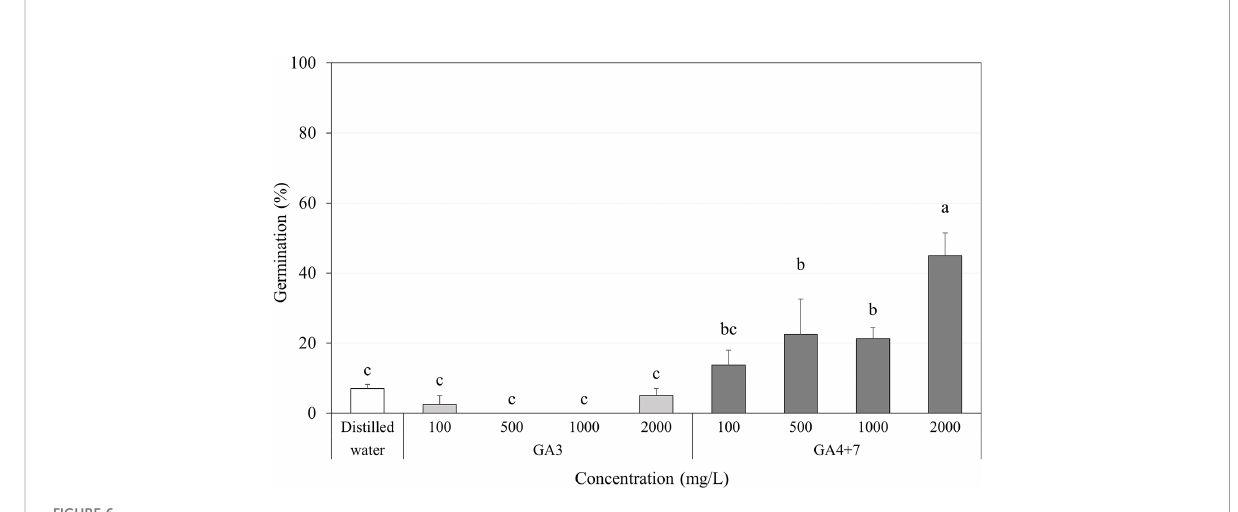
FIGURE 6 Percent germination of Amsonia elliptica seeds soaked in indicated concentrations of gibberellins (GAs) for 2 days. D.W., seeds soaked for 2 days in distilled water. Bars indicate standard errors ( n = 4). Different lowercase letters indicate a signi fi cant difference tested by Duncan ’ s multiple range test ( P < 0.05).